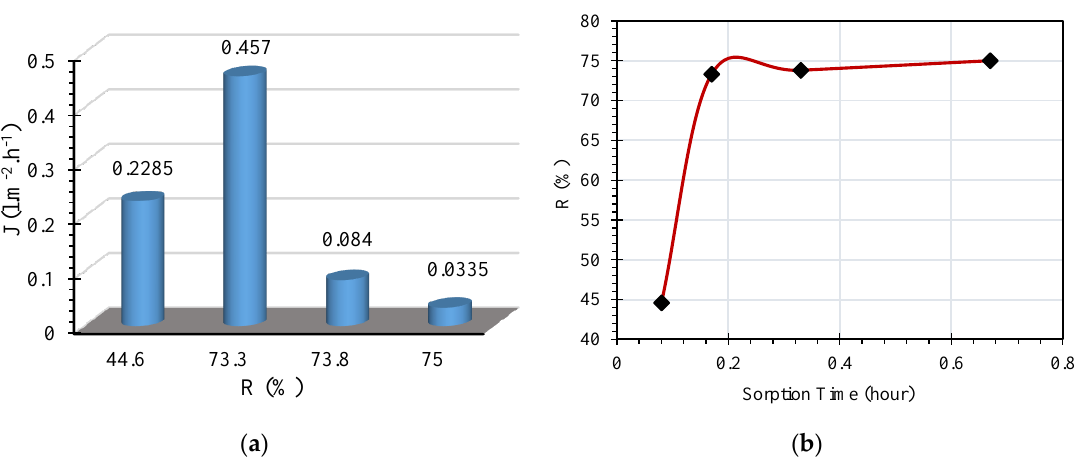
Figure 4. Illustration of the permeate flux and retention coefficient of the membrane. ( a ) Variation of the permeate flux with the retention coefficient. ( b ) Variation of the retention coefficient with sorption time. It is noticed that a retention coefficient of 75% is recorded by the RC membrane after one pass.